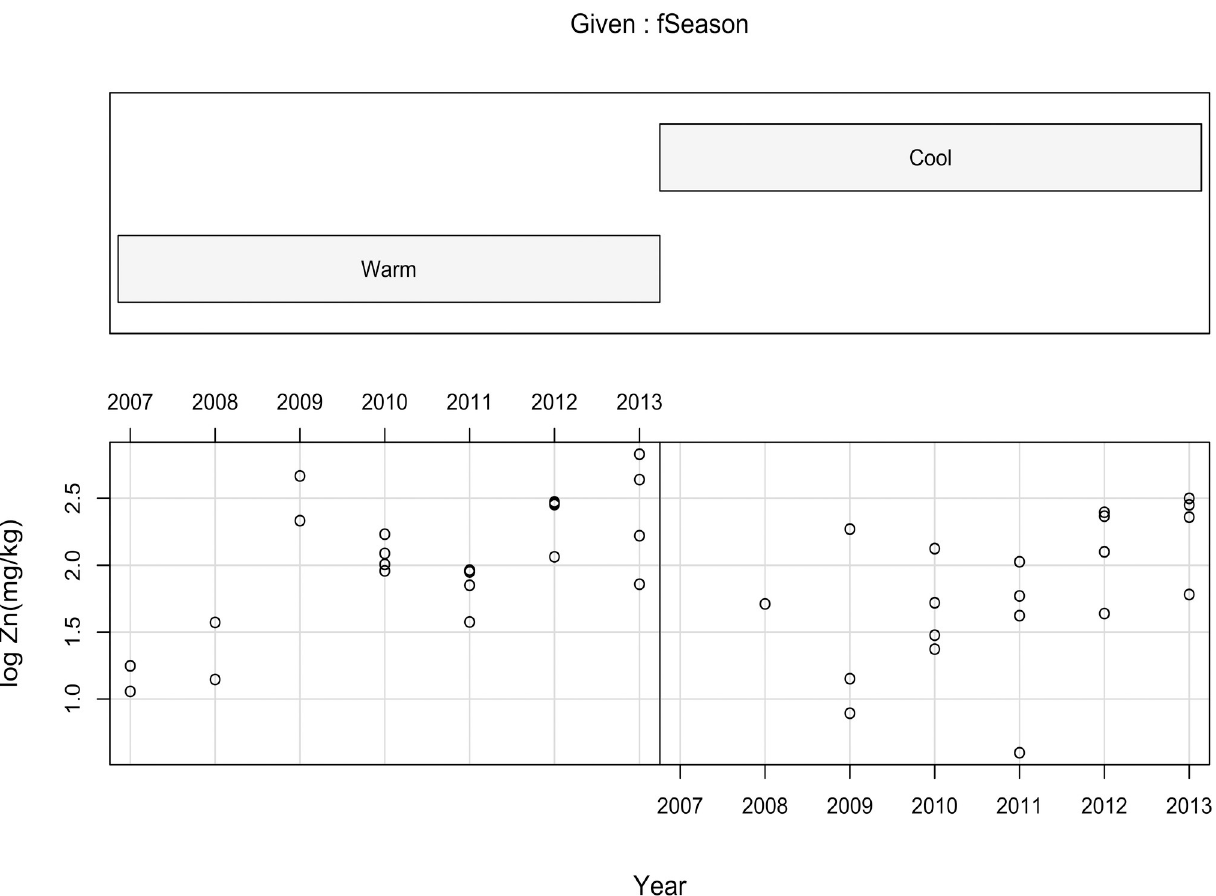
Fig 5. Conditioning plot showing the pattern of log 10 Zn deposition in surface sediments (mg kg -1 ) throughout the years 2007–2013 in the warm vs the cool seasons.